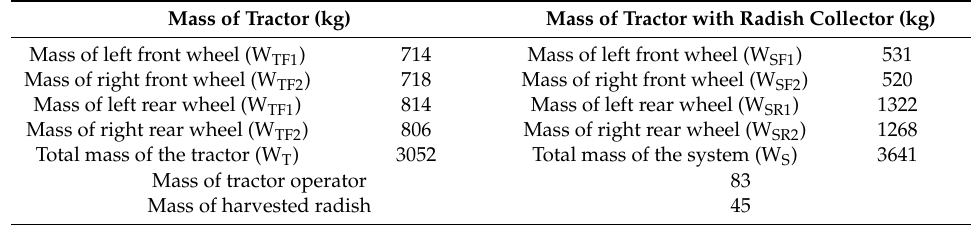
Table 3. Factors considered during the simulation of lateral overturning stability of the tractor– collector system.